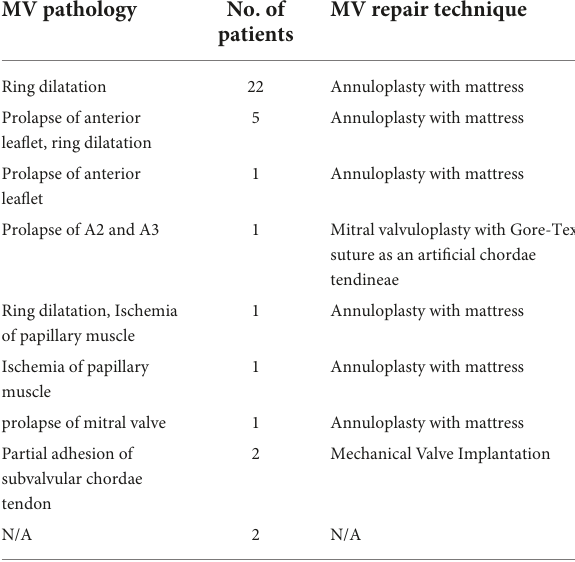
TABLE 1 MV pathology and operative techniques of MV repair in all 36 patients of group